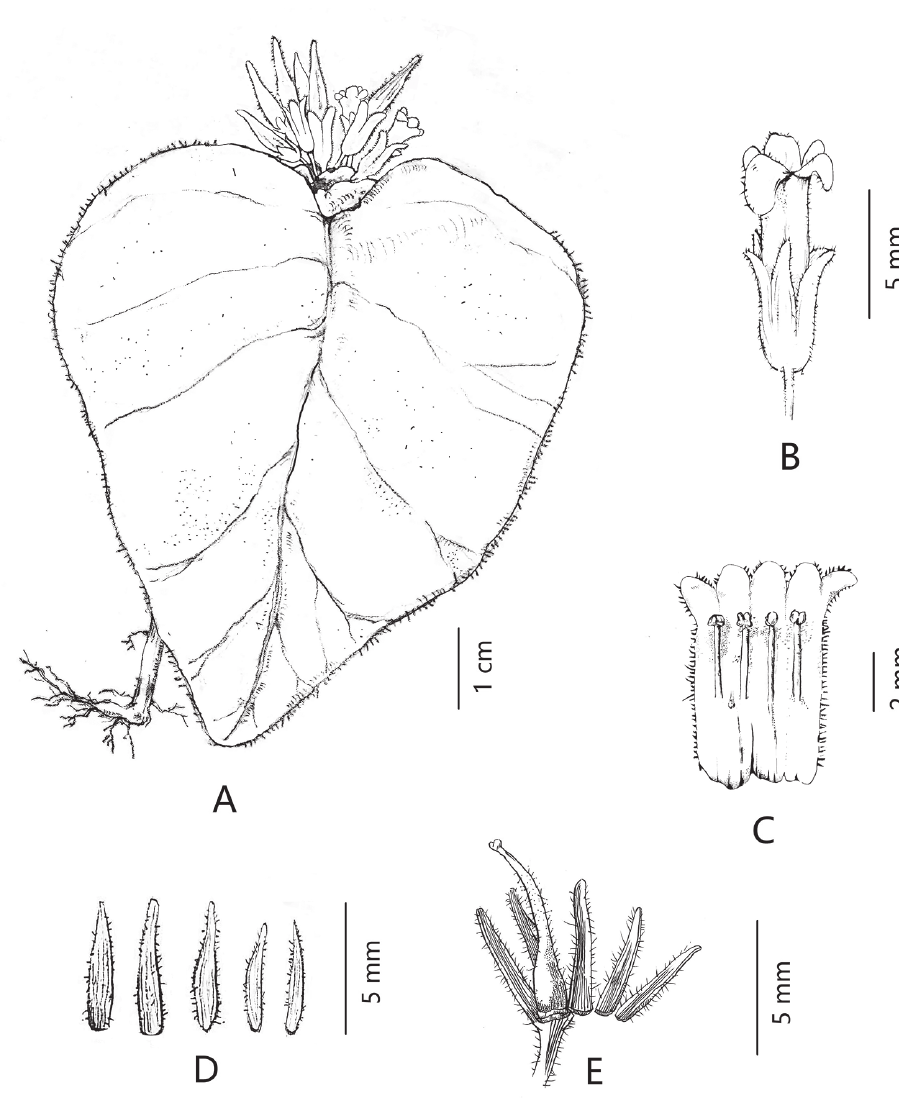
Figure 1. Microchirita minor sp. nov. A habit B flower C opened corolla with stamens and staminodes; D abaxial surface of calyx lobes E pistil and calyx. Drawn by Rui-Feng bracts absent; pedicels pale green, 4–6 mm long, densely glandular and eglandular pubescent. Calyx 5, segments unequal, upper lobes 3-parted to near the base, lower lobes 2-parted to the base, the central upper lobe (alternate to the upper corolla lobes) shorter and thinner than the other lobes, pale green, lobes lanceolate, larger lobes 5–7× ca. 1 mm, smaller lobes ca. 4 × 0.6 mm, apex acuminate, margin entire, densely glandular and eglandular pubescent outside, glabrous inside. Corolla 8–10 mm long, tube white, with four yellow patches inside the tube, each one of them originating at